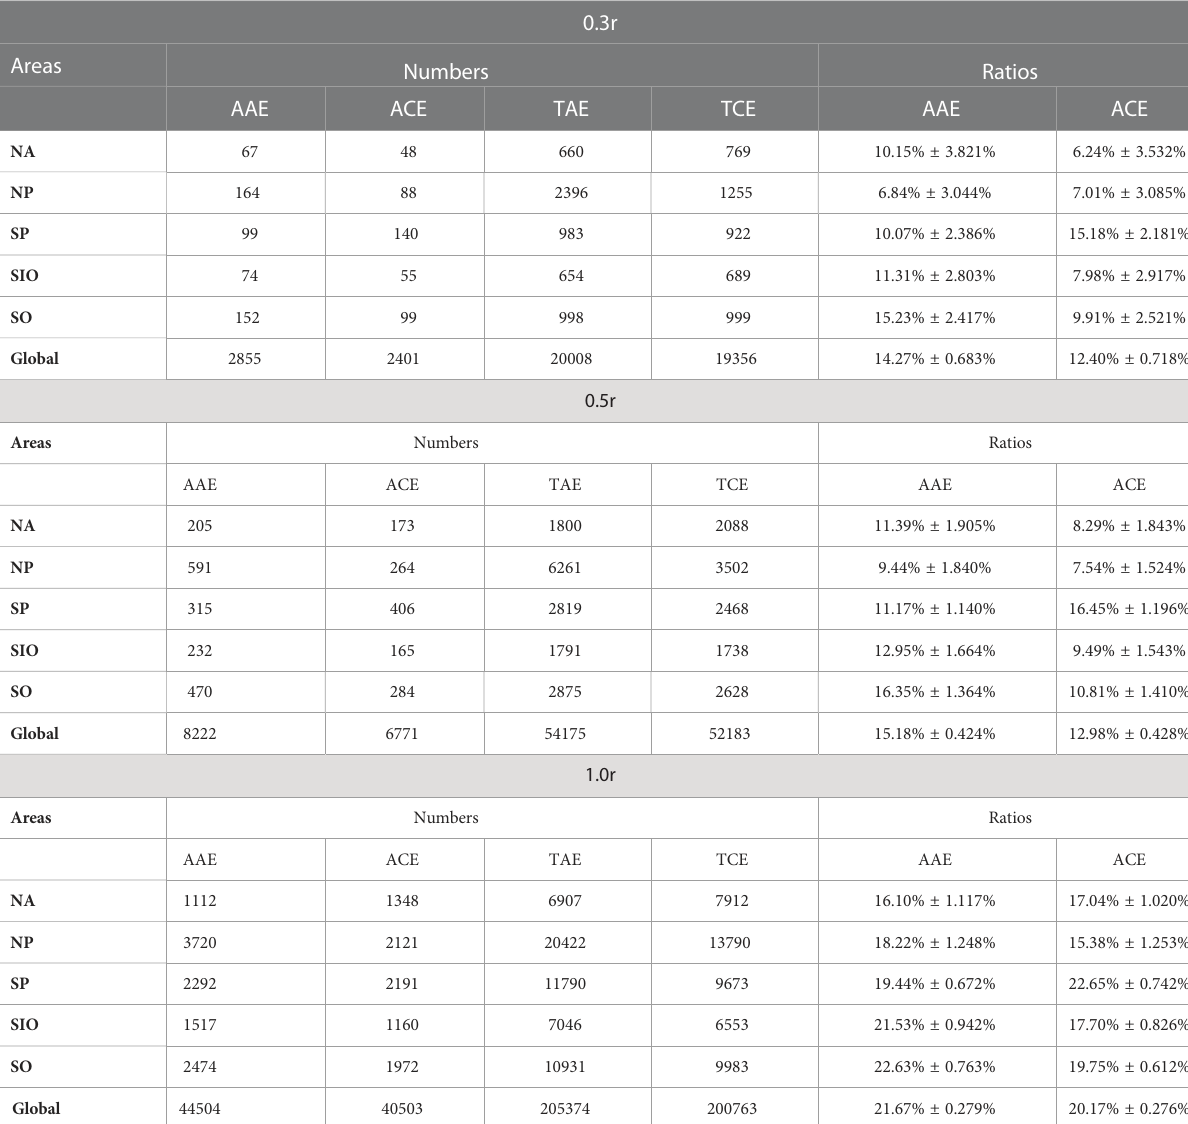
TABLE 1 The numbers and ratios of abnormal eddies with different relative radius in fi ve regions and globally.